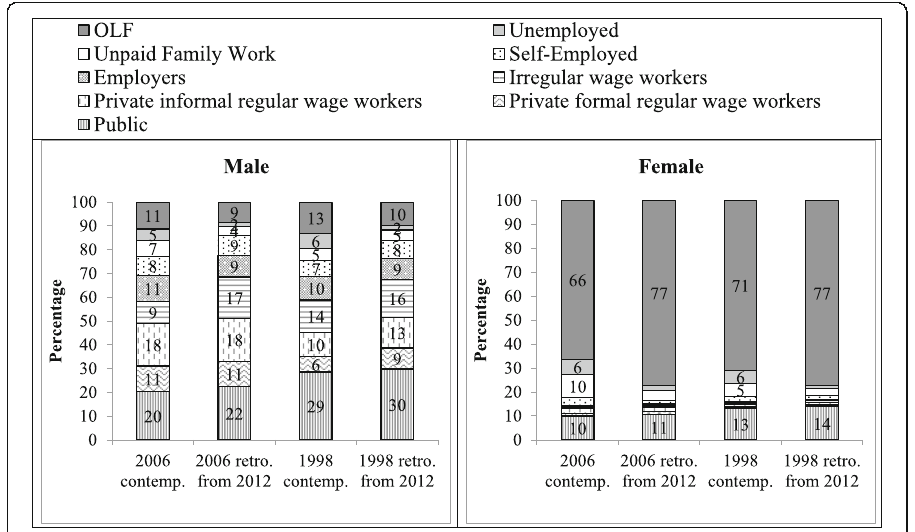
Fig. 4 Labor market status, as reported contemporaneously for 1998 and 2006 and as reported retrospectively for those years from 2012 data, by sex, individuals aged 20 – 44 in 1998 or 2006 and present in both waves (percentage). Source: Authors ’ calculations based on ELMPS 1998, ELMPS 2006 and ELMPS